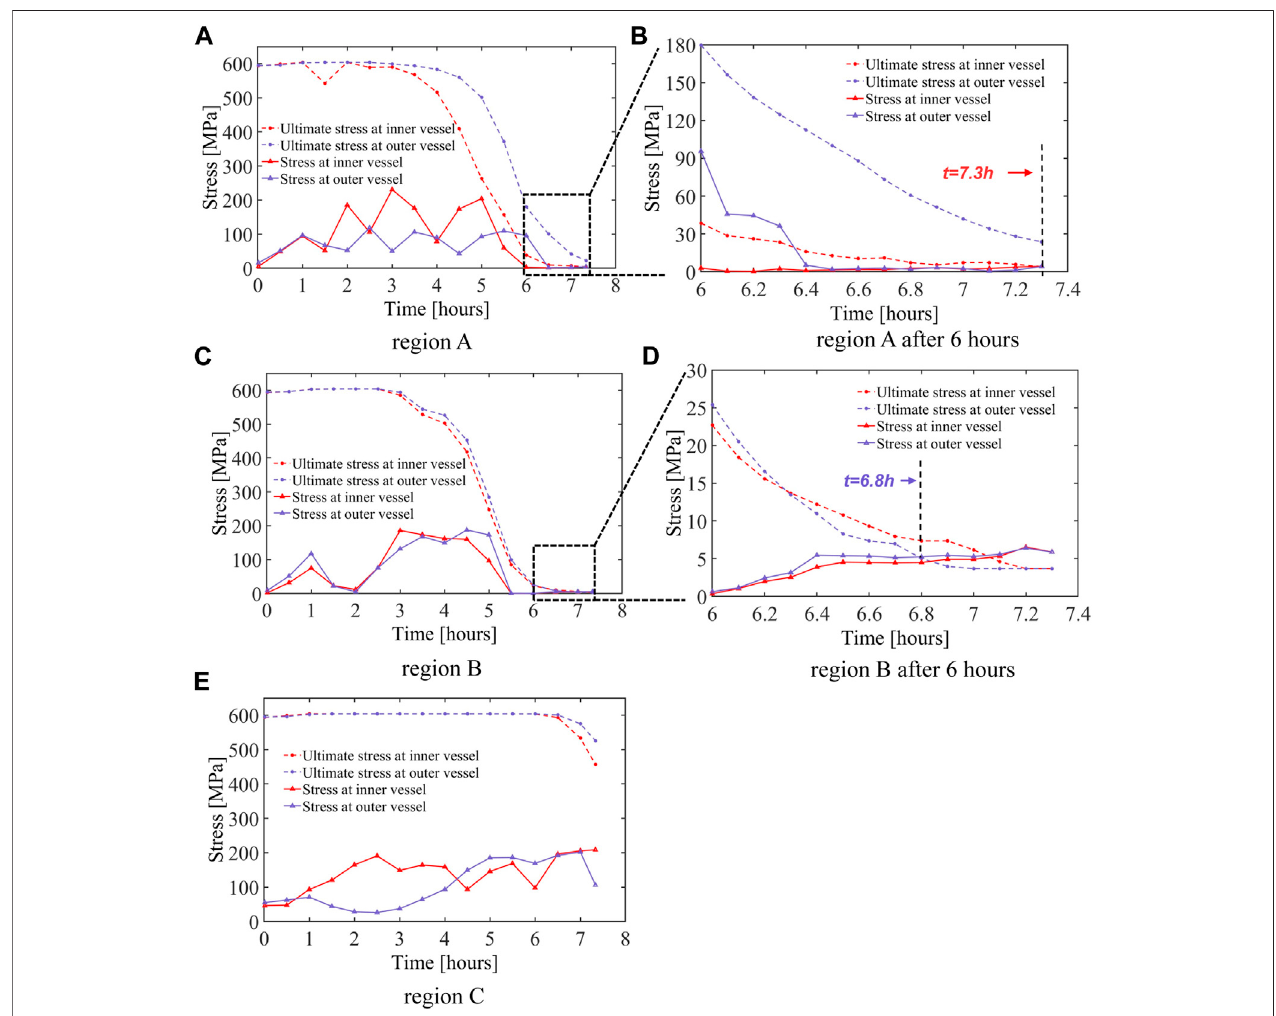
FIGURE 10 | Comparison of von Mises stress of the vessel and SA533B1 ultimate stress at the critical regions for the SBO case; (A) region A, (B) zoomed-in version of region A after 6 h, (C) region B, (D) zoomed-in version of region B after 6 h, and (E) region C.